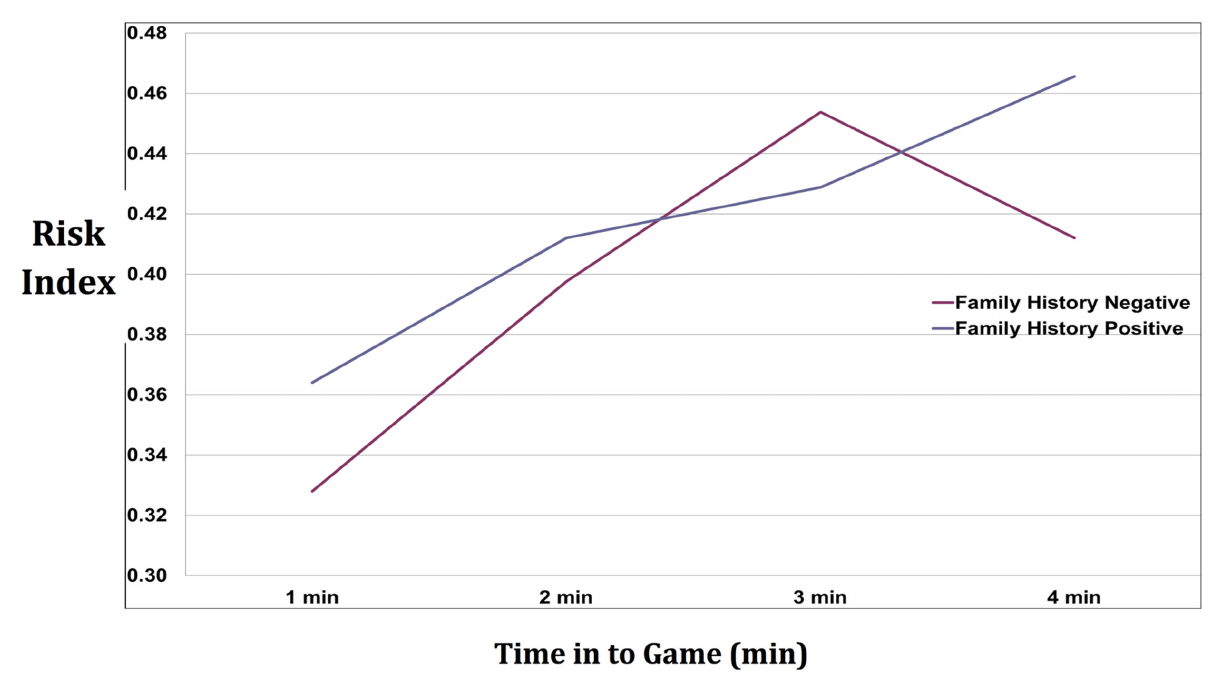
Figure 2. Risk indices by group (Family History Positive and Family History Negative) over time in to game. Risk Index was derived by dividing number of non-match choices by number of total choices when non-match and match choices were available to the player. FHP (a) and FHN (b) data are plotted by minute into game with standard error (averaged for all games for all subjects). No significant differences were found between groups. There was a significant main effect of time across groups (F=9.58, df=3, 201, p , .0001).